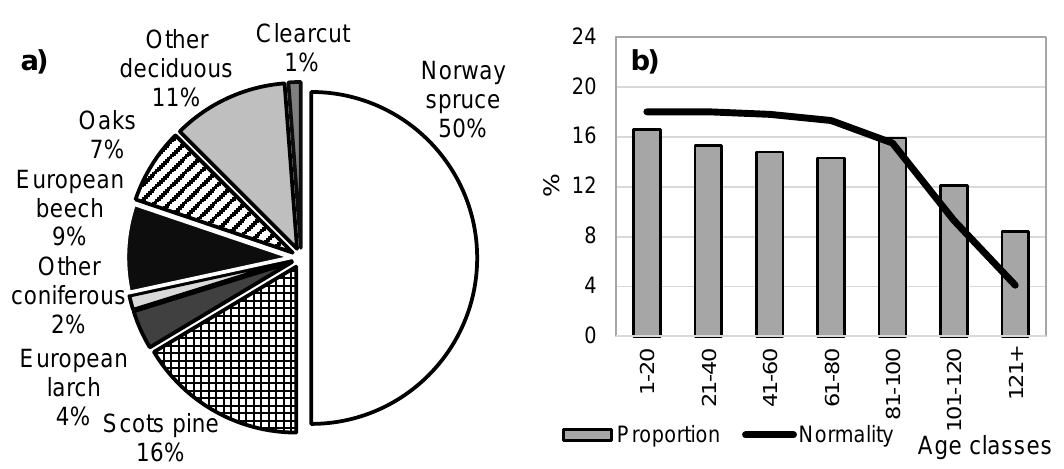
Figure 1. Current status (2018) of ( a ) tree species composition and ( b ) proportion of age classes to normality in the Czech Republic.